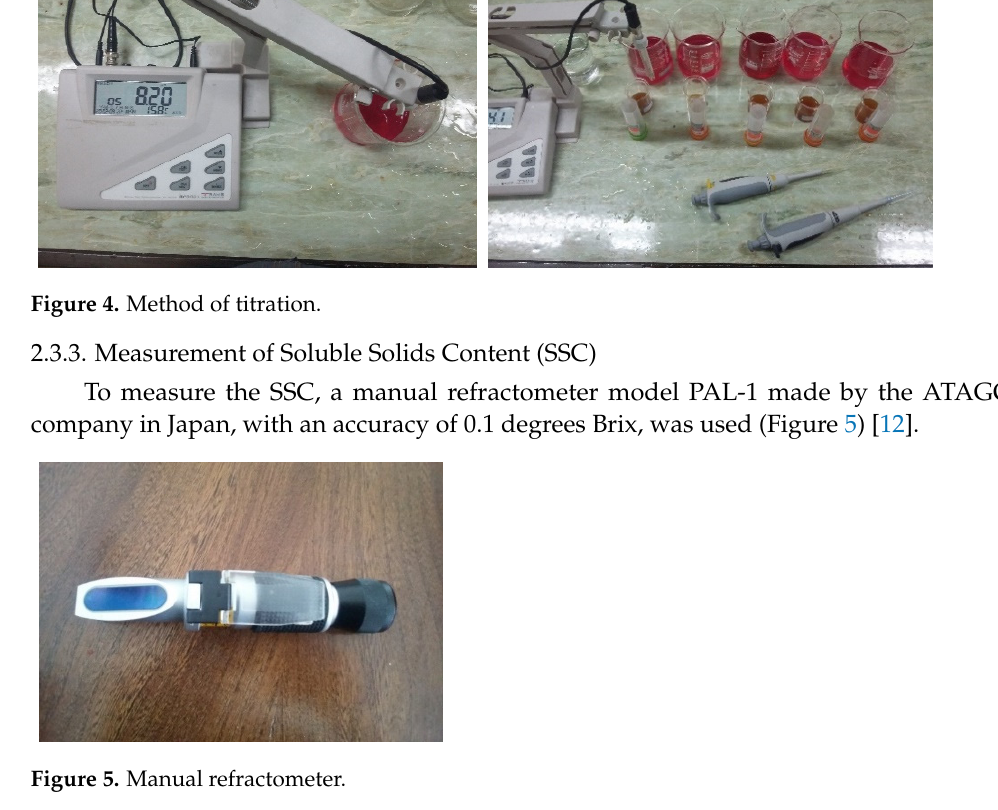
Figure 5. Manual refractometer.